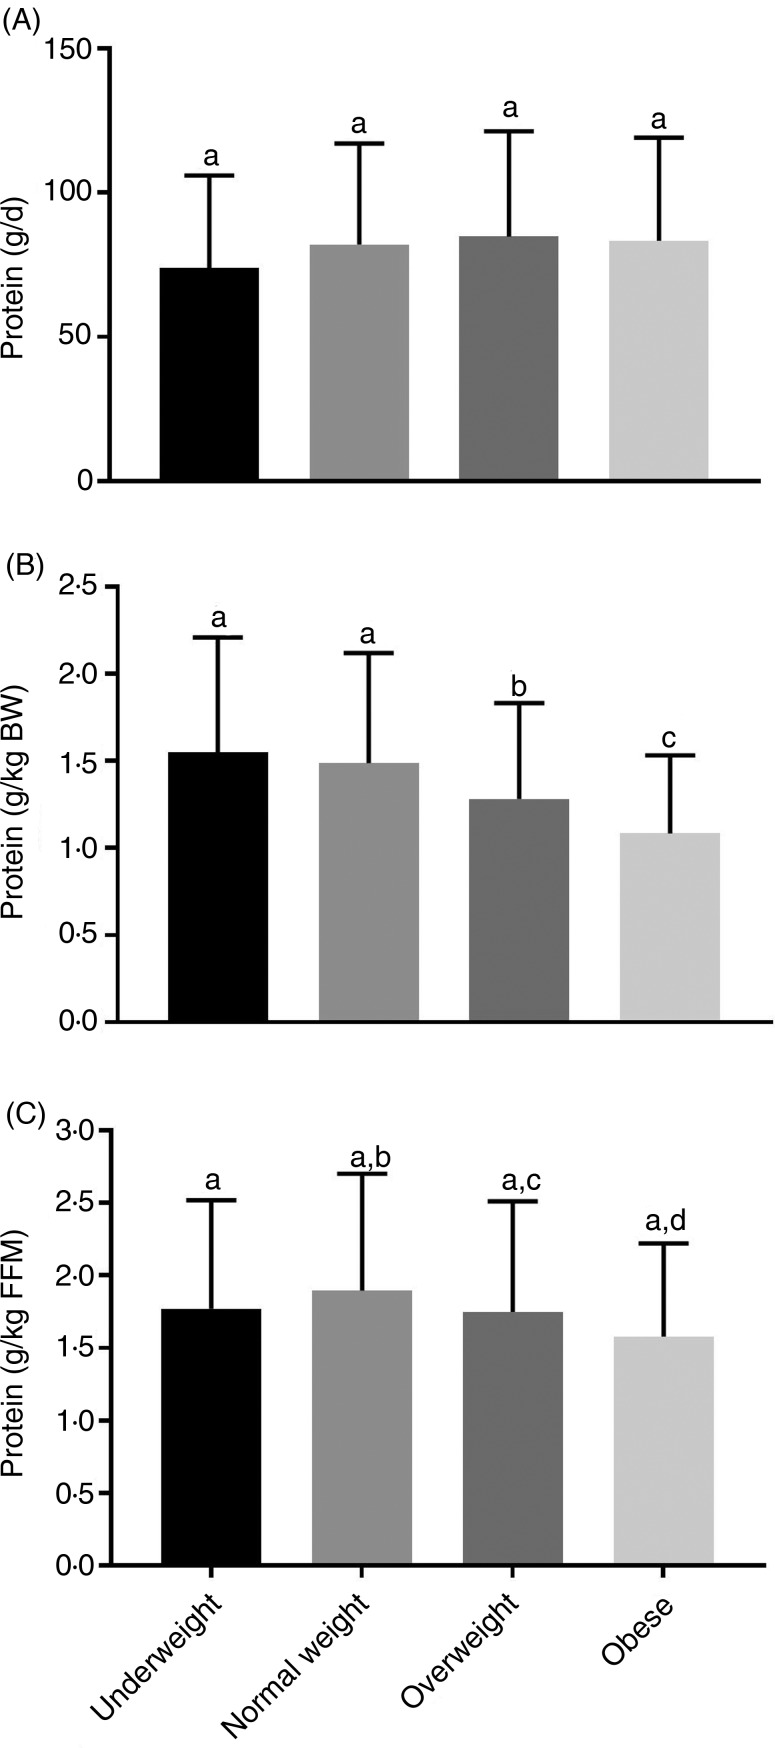
Dietary protein by BMI category. Relative protein intake (g protein/d) (A) was not significantly different across all BMI categories. Adjusting for body weight (BW) (B), underweight and normal-weight BMI categories had significantly greater relative dietary protein compared with overweight and obese BMI categories. Adjusting relative to fat-free mass (FFM) (C), normal-weight participants had significantly greater protein intake than overweight and obese participants. Underweight, n 59; normal weight, n 633; overweight, n 803; obese, n 214. Values are means, with standard deviations represented by vertical bars. a,b,c,d Mean values with unlike letters were significantly different (P < 0·05).